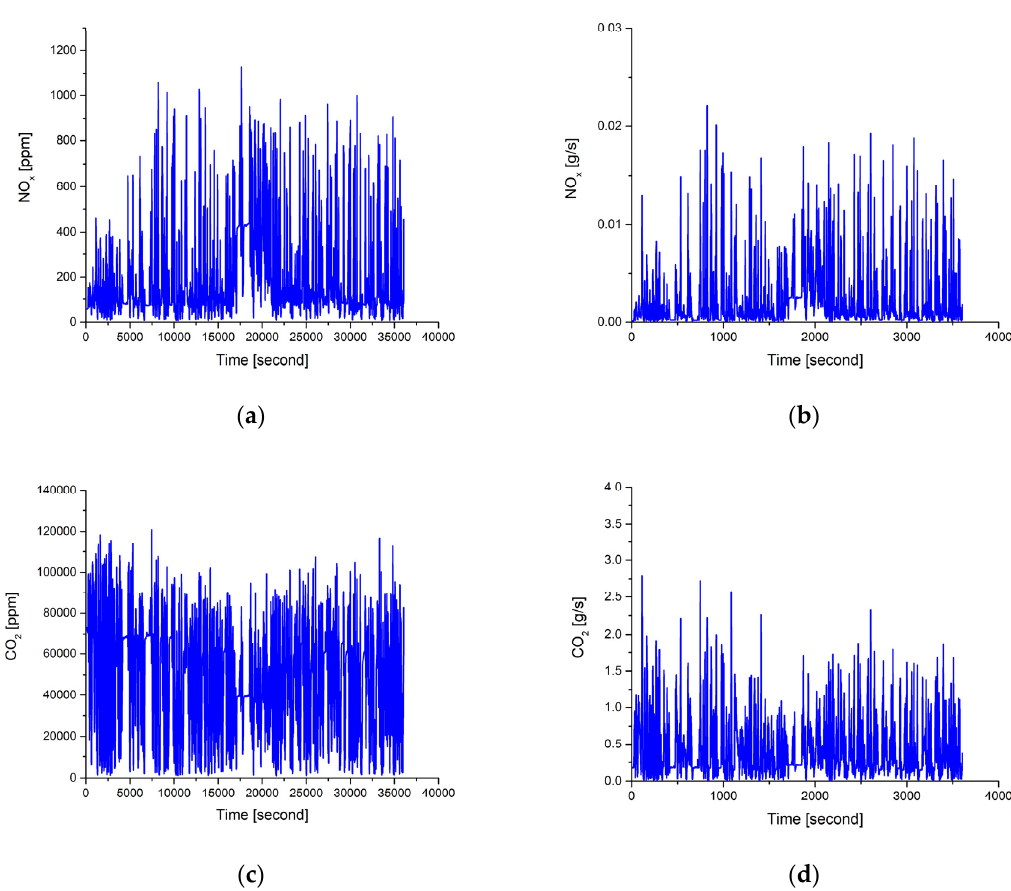
Figure 4. The instantaneous concentrations and the production rates of NO x and CO 2 in urban part. ( a ) NO x concentrations (ppm); ( b ) NO x production rates (g/s); ( c ) CO 2 concentrations (ppm); ( d ) CO 2 production rates (g/s) .